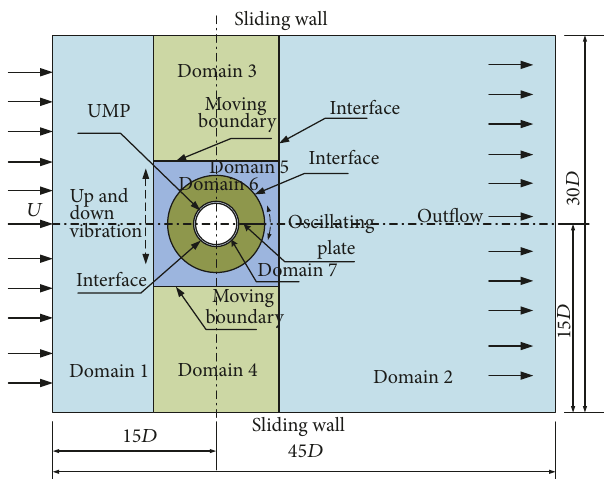
Figure 3: Computational domain and boundary conditions.